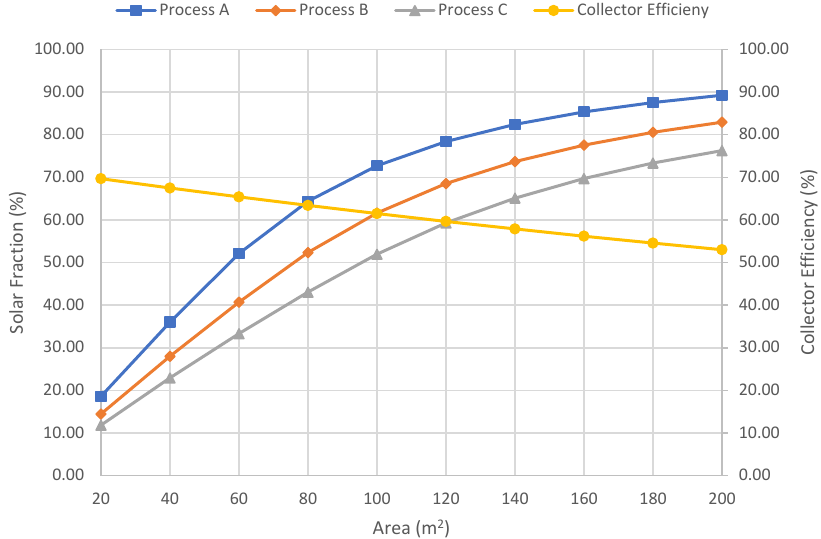
Figure 8. Effect of varying FPC area on collector efficiency and SF. Table 3. Optimized area of each process.